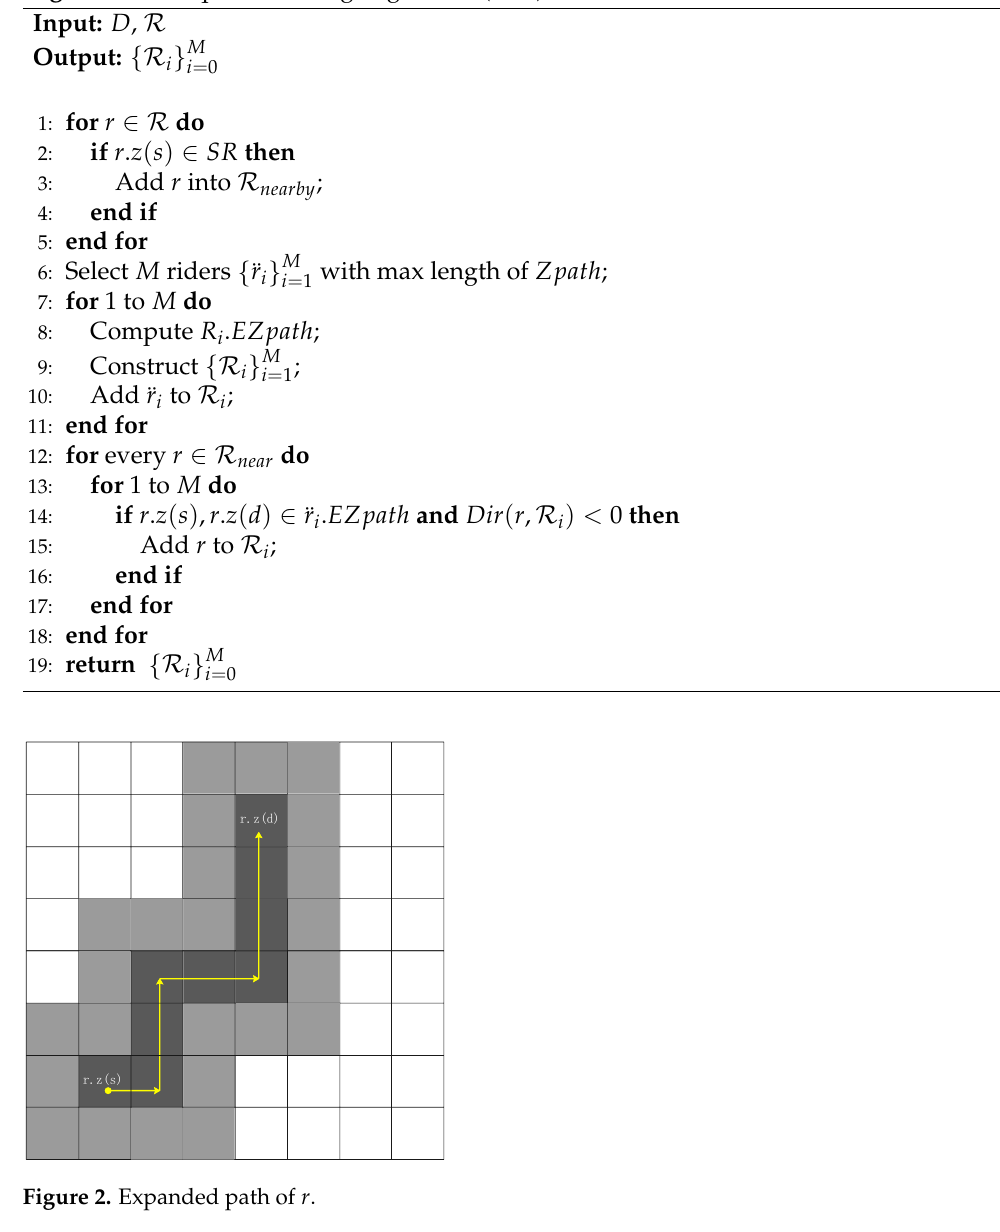
Algorithm 1 Request Filtering Algorithm ( RFA ).